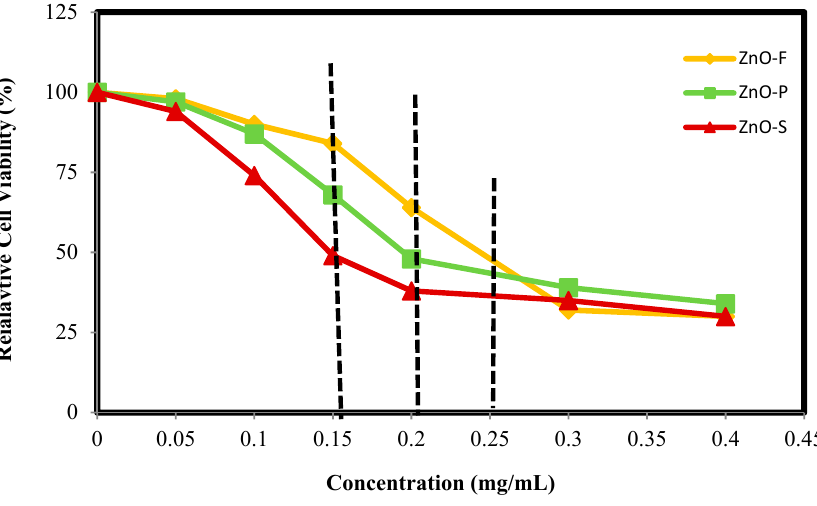
Figure 7. Cytotoxic effect of ZnO-NPs samples on the growth of 3T3 cells .